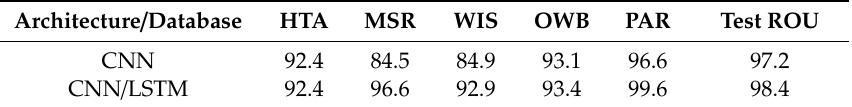
Table 11. Hyperparameter test accuracy results when training on the TrainROU dataset while using accelerometer measurements only.